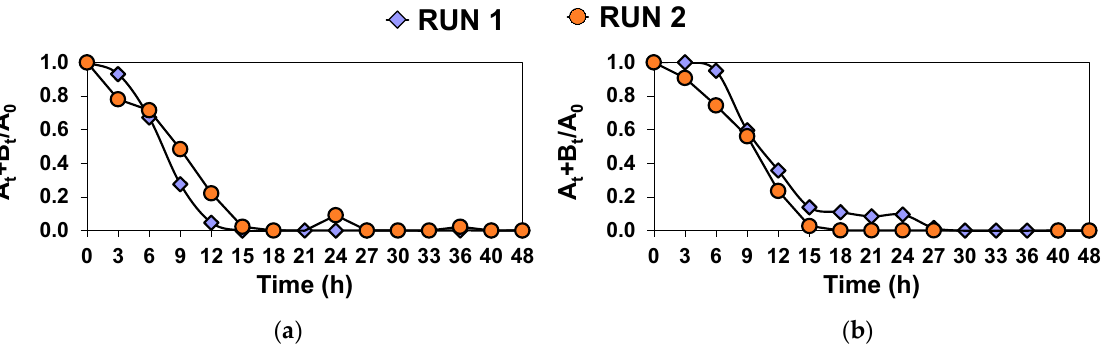
Figure 4. Ratio of NO 3 –N and NO 2 –N degradation profiles from batch testing in ( a ) reactor A and ( b ) reactor B.